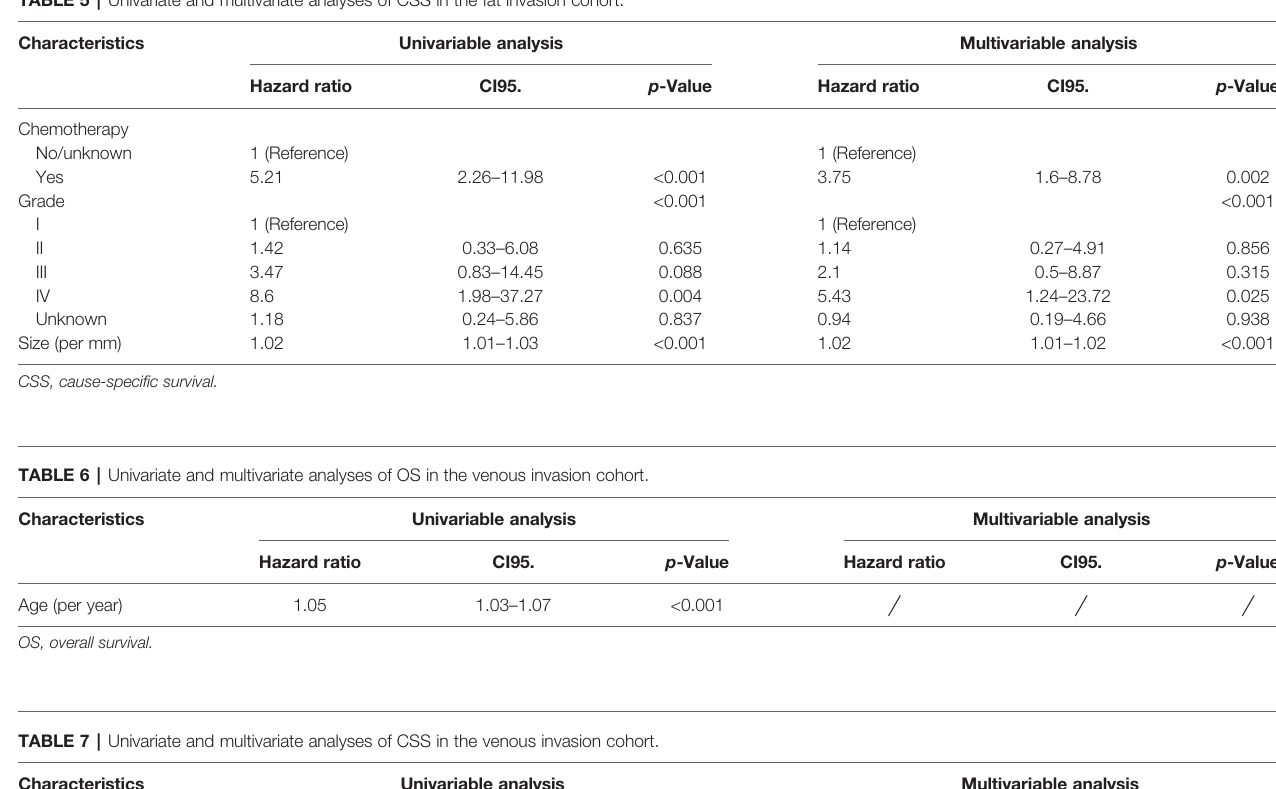
TABLE 5 | Univariate and multivariate analyses of CSS in the fat invasion cohort.